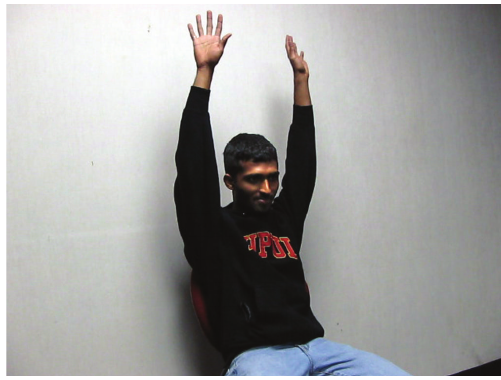
Figure 6: The first author demonstrates a typical position of a participant in the